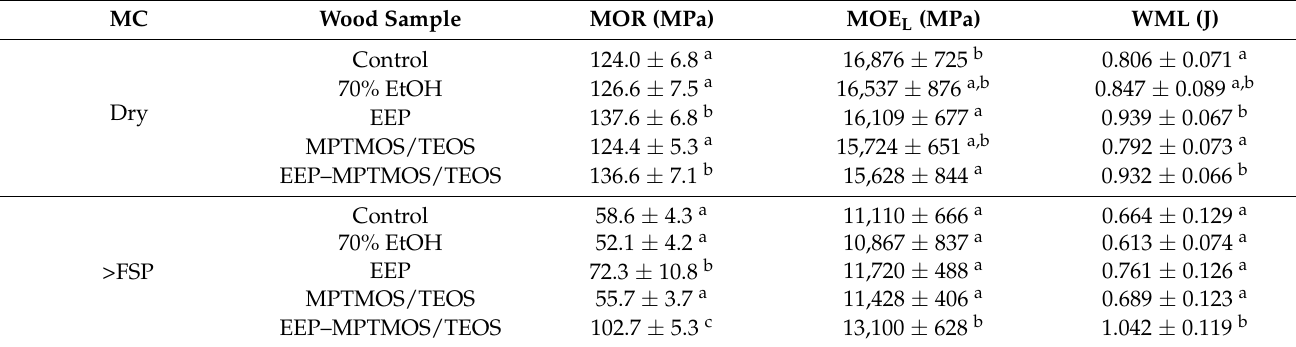
Table 2. Mean values of modulus of rupture (MOR), modulus of elasticity (MOE), and work to maximum load (WML) for treated wood in different moisture content